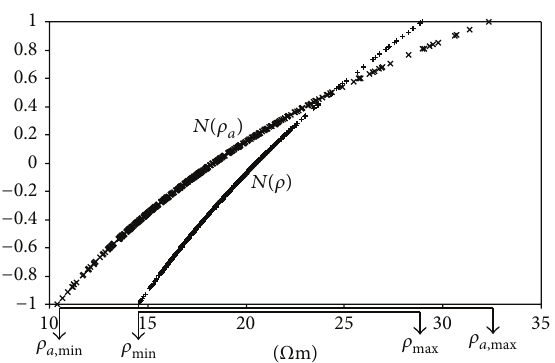
Figure 3: Pattern of the normalizing 𝑁(𝜌 𝑒 ) function applied to a set of apparent resistivity values and to the corresponding set of first- step resistivity values.